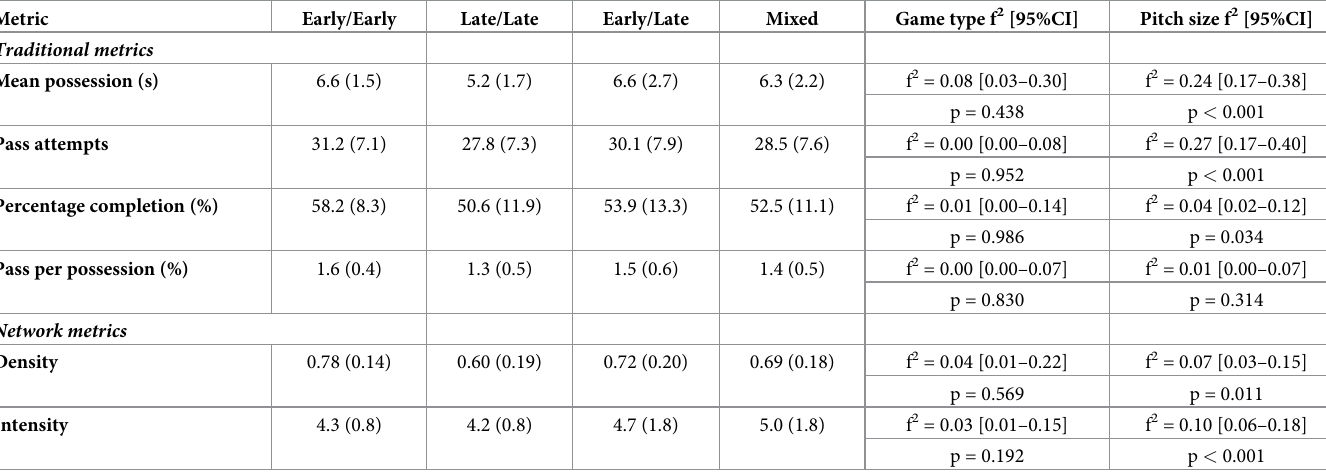
Table 1. Team-based traditional and network passing metrics and the effects of game type and pitch size.